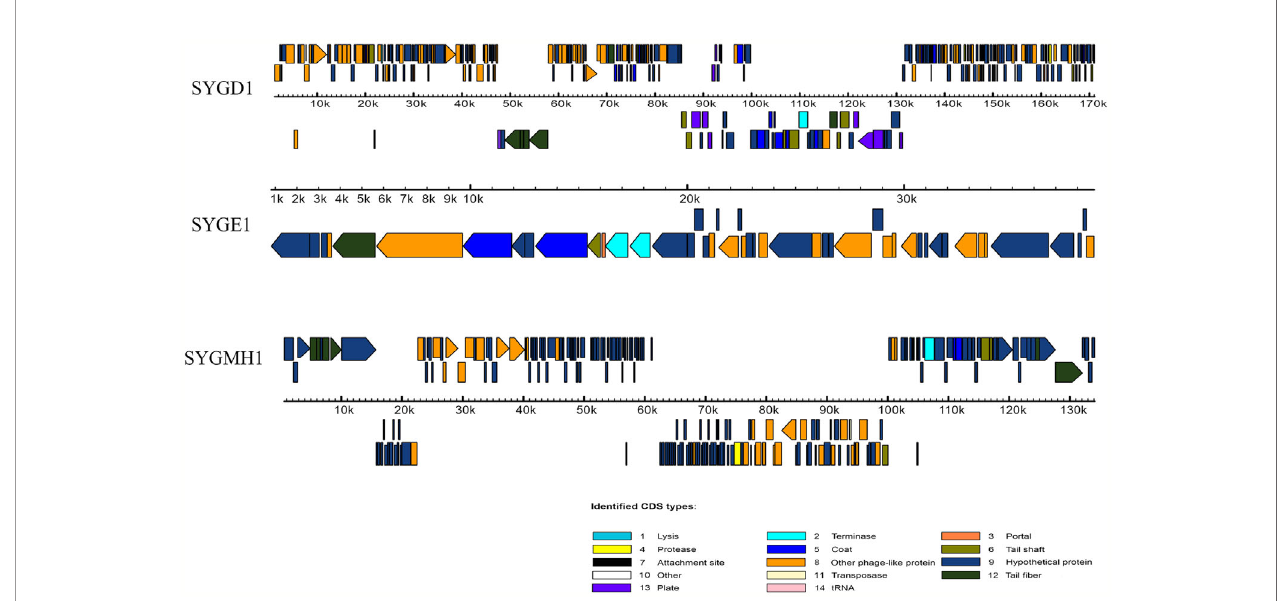
FIGURE 2 | Genome features of vB_EcoM_SYGD1, vB_EcoP_SYGE1 and vB_EcoM_SYGMH1. Their predicated ORFs and their orientations are represented by arrows. The function modules are shown in different colors.